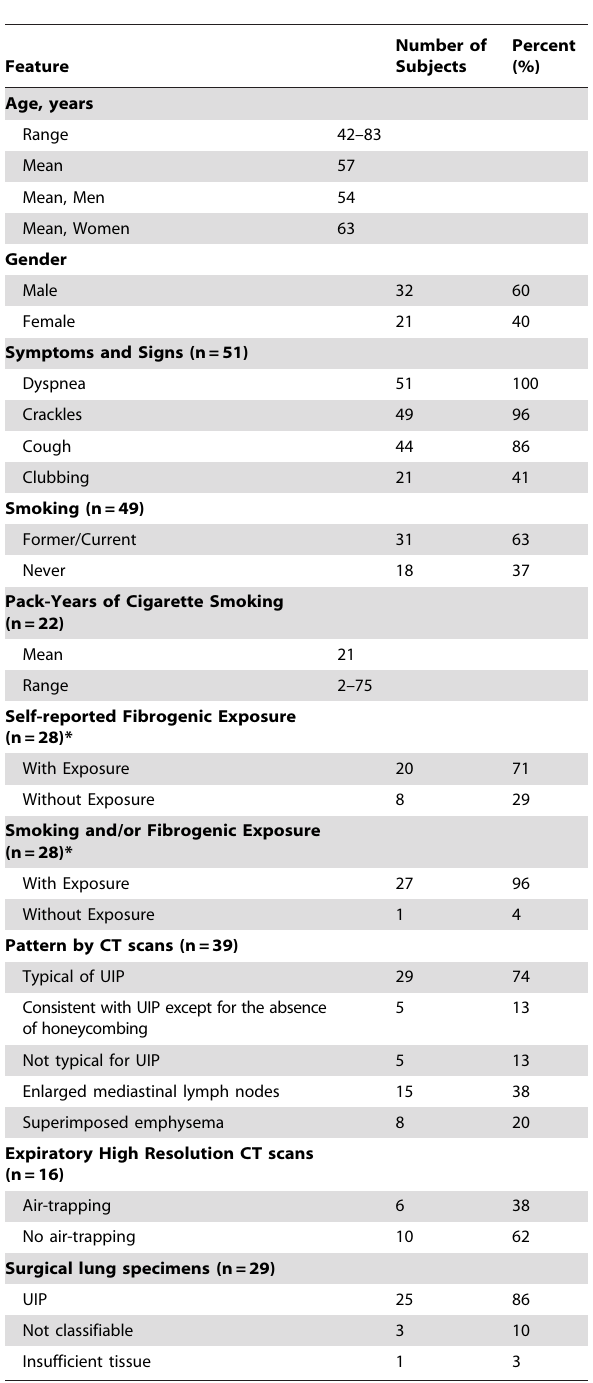
Table 2. Features of 53 TERT mutation carriers with pulmonary